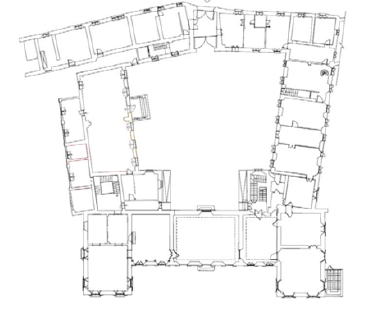
Figure 1 . Plan of the Trotti Palace